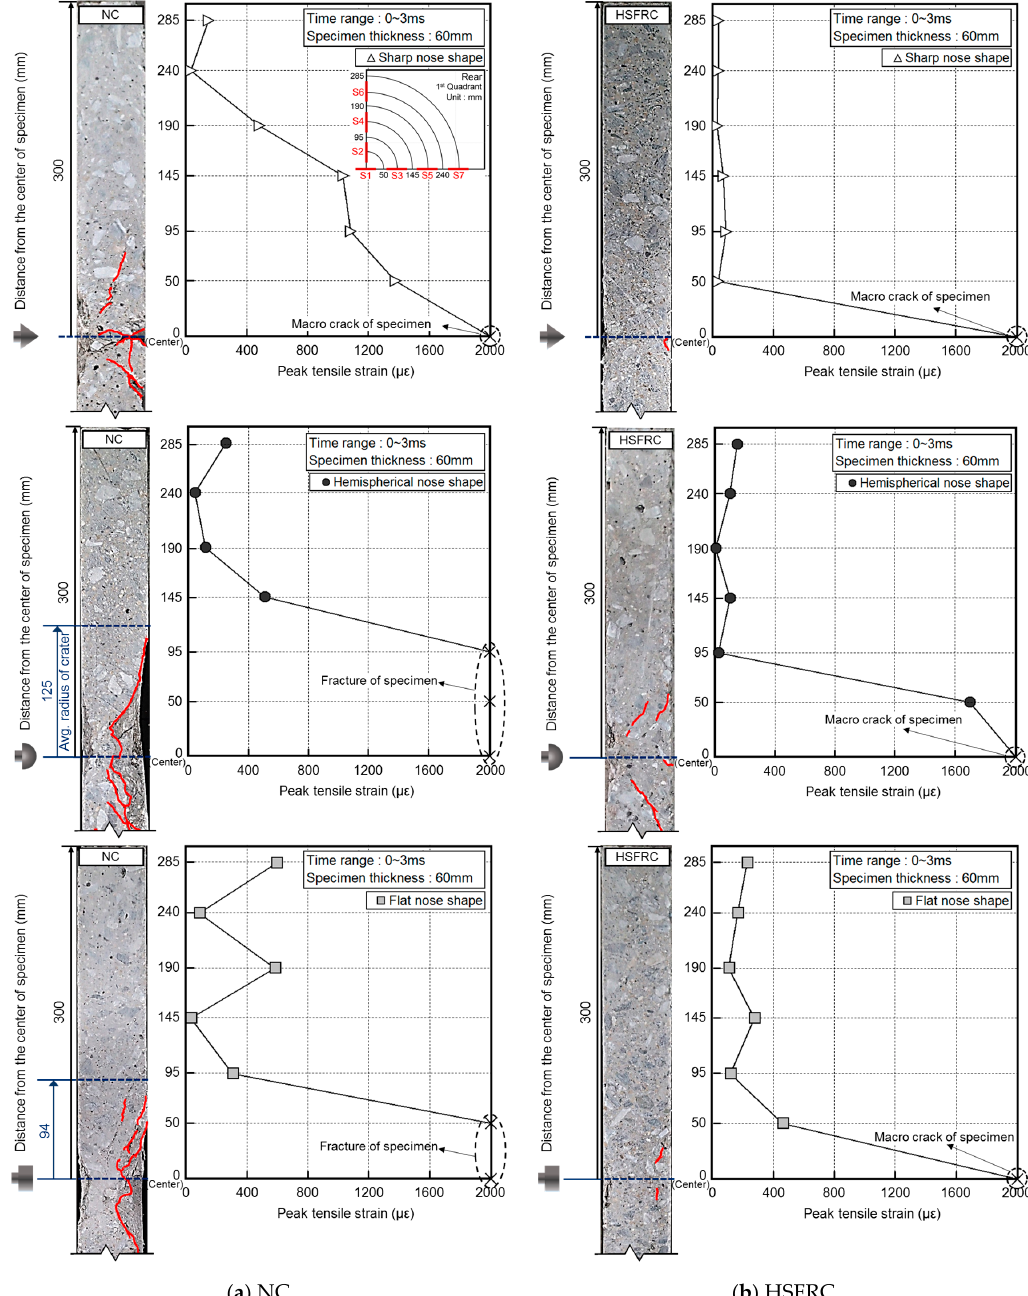
Figure 14. Relationship between cracks on the cross section and peak tensile strain on the rear